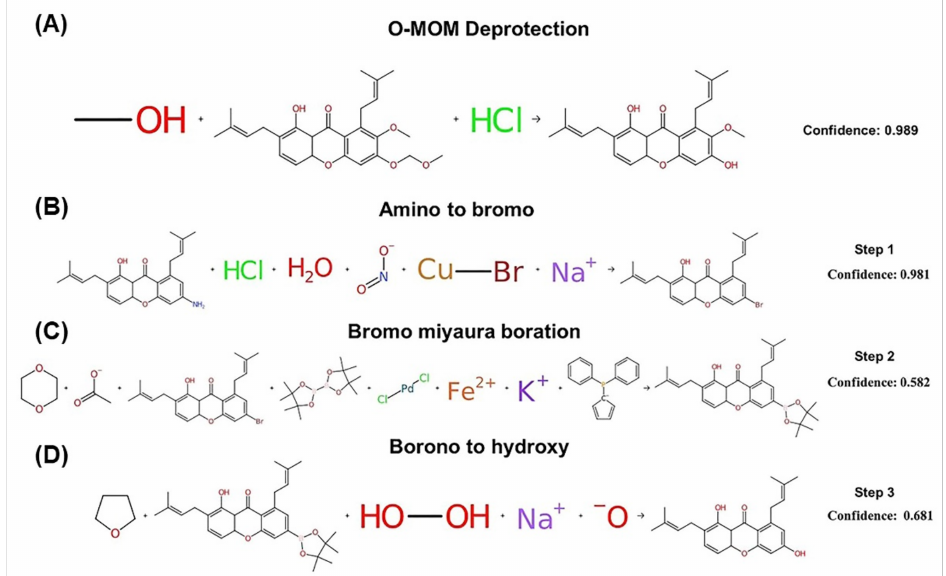
Figure 5. Planning synthesis of compounds: ( A ) 1,6-dihydroxy-7-methoxy-2,8-bis(3-methylbut-2- en-1-yl)-9H-xanthen-9-one, ( B )